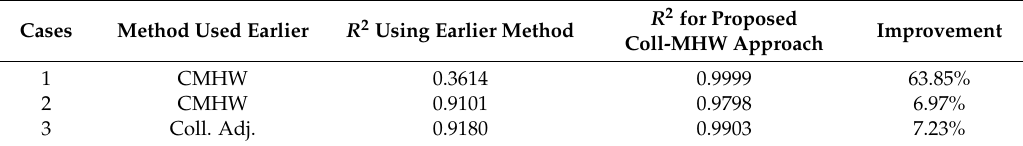
Table 7. Improvement in the coefficient of